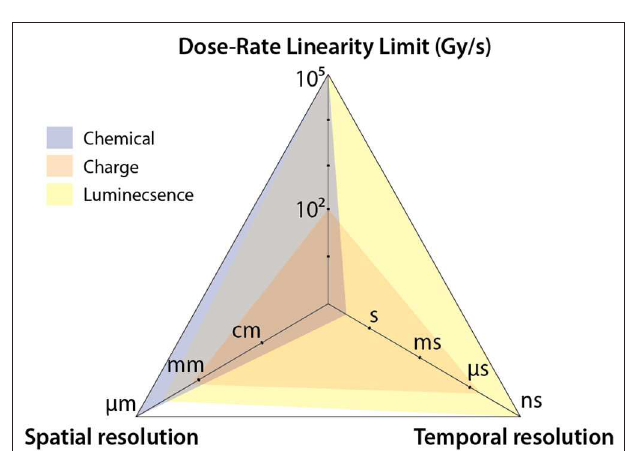
FIGURE 2 | Spider plot comparing the three different categories of detector. The axes denote major dosimetric issues associated with FLASH. It can be seen that luminescent detectors can provide ∼ ns time-resolution, with sub-millimeter resolution and dose-rate independence up to a dose rate of 10 5